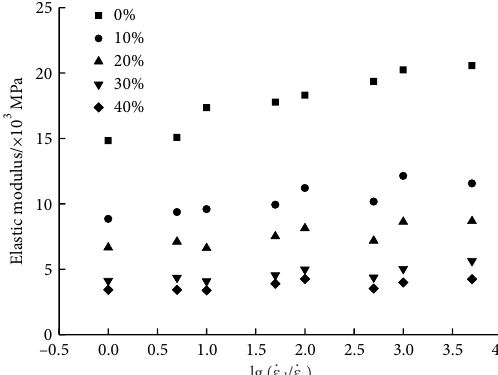
Figure 12. Effect of strain rate on elastic modulus